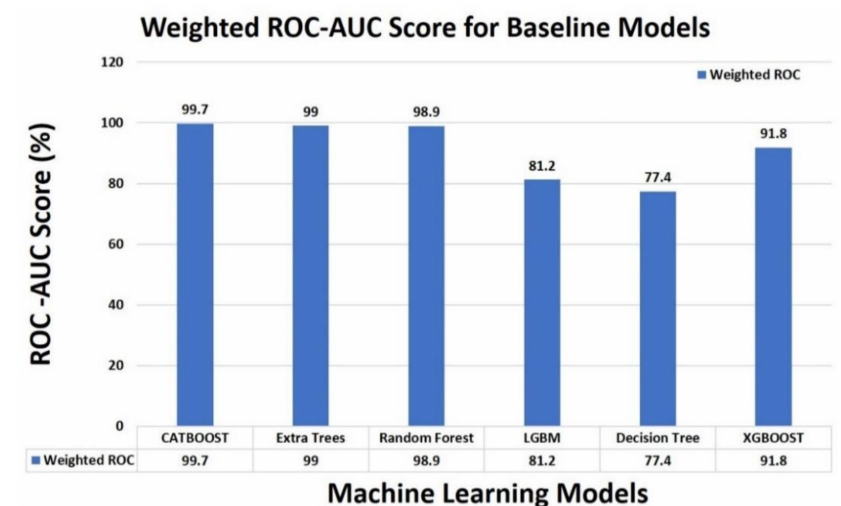
Figure 5. Baseline model weighted ROC-AUC Score